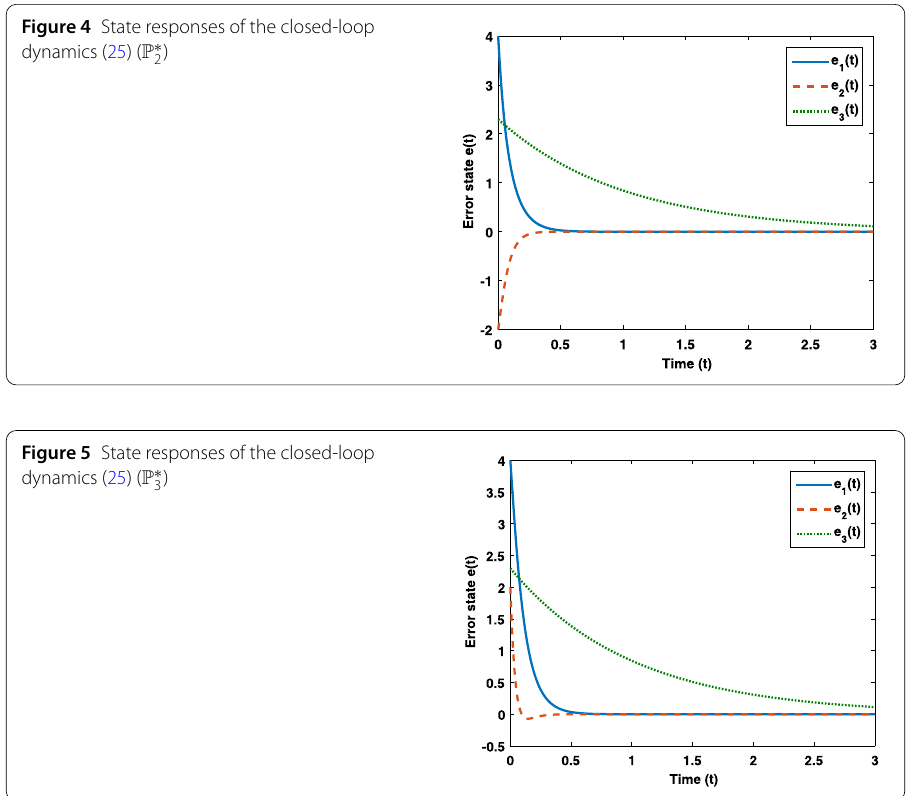
Figure 4 State responses of the closed-loop dynamics (25) ( P ∗ 2 )